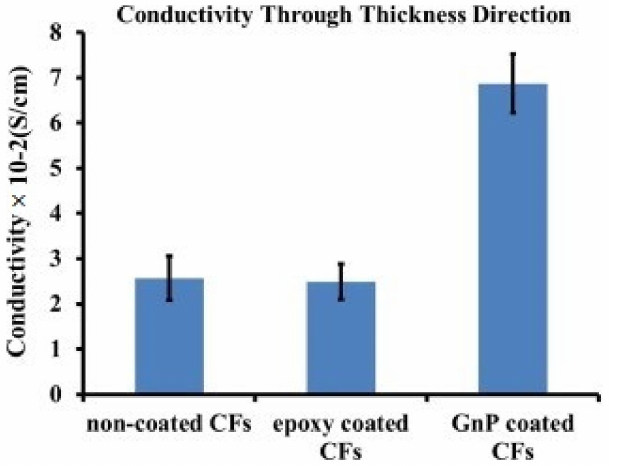
Figure 11. Electrical conductivity of noncoated, epoxy-coated, and GNPs-coated carbon fiber surfaces [46]. Obtained with permission from Composites Part B: Engineering; published by Elsevier, 2015. Table 3. Listed electrical conductivity of CFRPs with